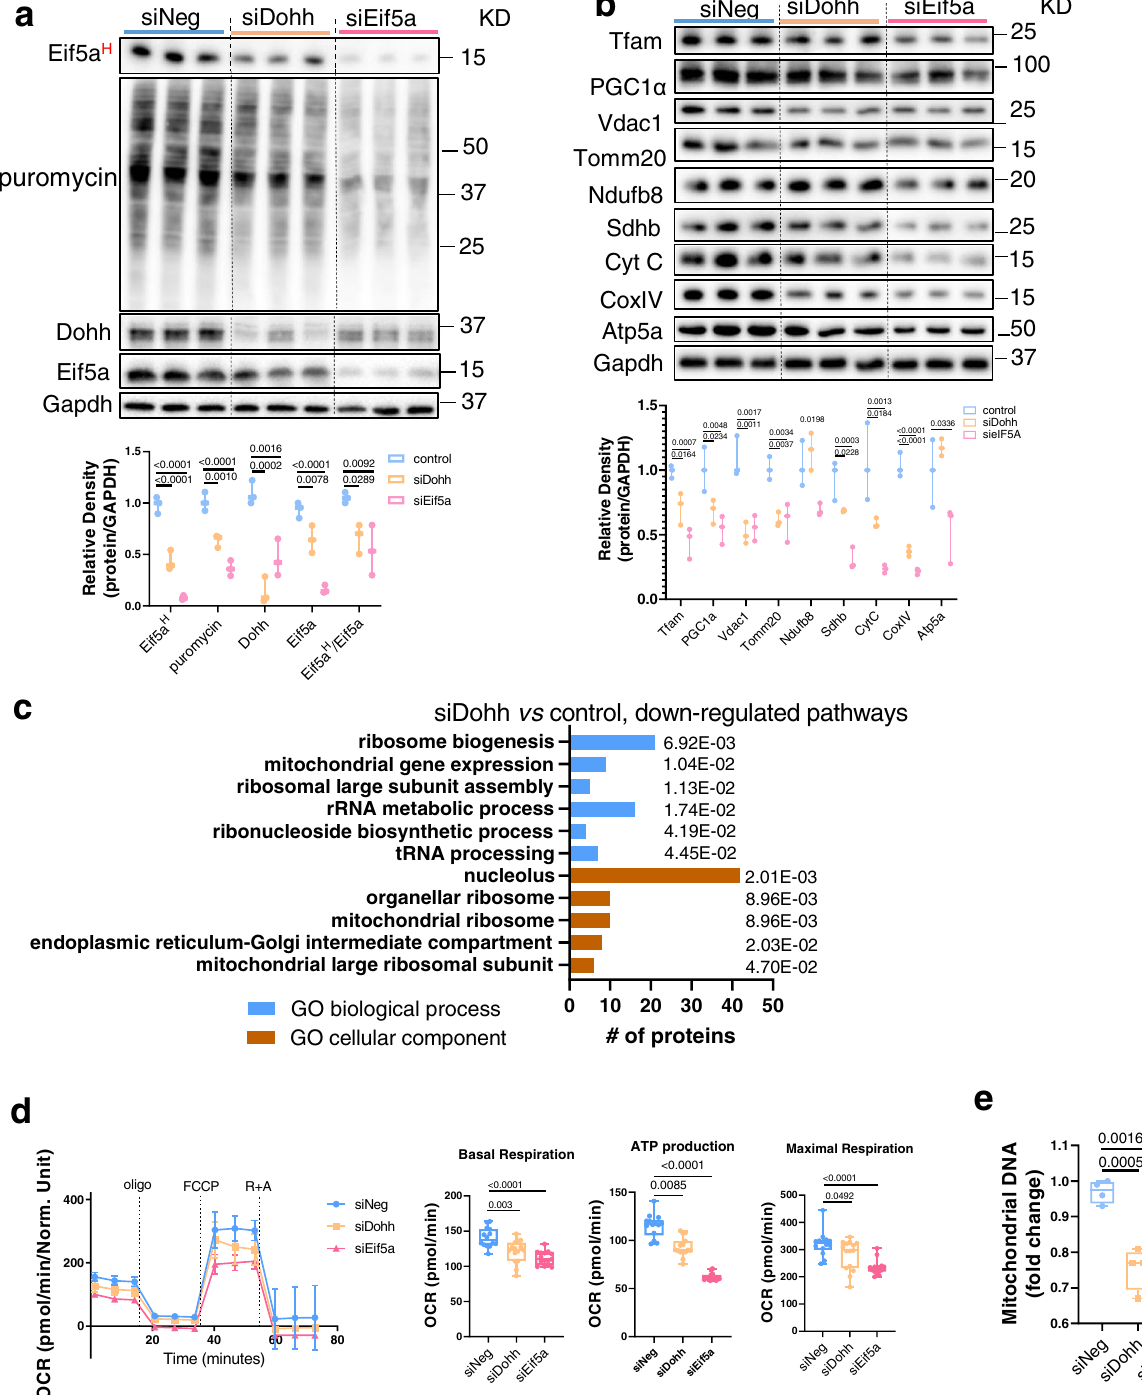
ohh eg 5a i f s i N s i E s i D Bonferroni correction was applied to correct for multiple testing. d Agilent Sea- horse XF Mito Stress Test measurement of mitochondrial OXPHOS. Oligomycin (oligo), FCCP, rotenone (R), and antimycin A (A) were used at 1 µ M each. ( n =15). Linegraphispresentedasmeanvalue±SEM. e MitochondrialDNAcopynumberin Dohh or eIF5A knockdown cells. ( n =4). a , b , d , e Data were shown as box-and- whisker with median (middle line), 25th – 75th percentiles (box), and min-max values(whiskers).Signi fi cancewascalculatedbyone-wayANOVAorKruskal – Wallis test, as appropriate. Source data are provided as a Source Data fi